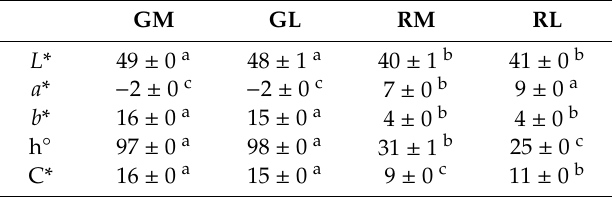
Table 2. Color parameters of the cactus pear residue tablet